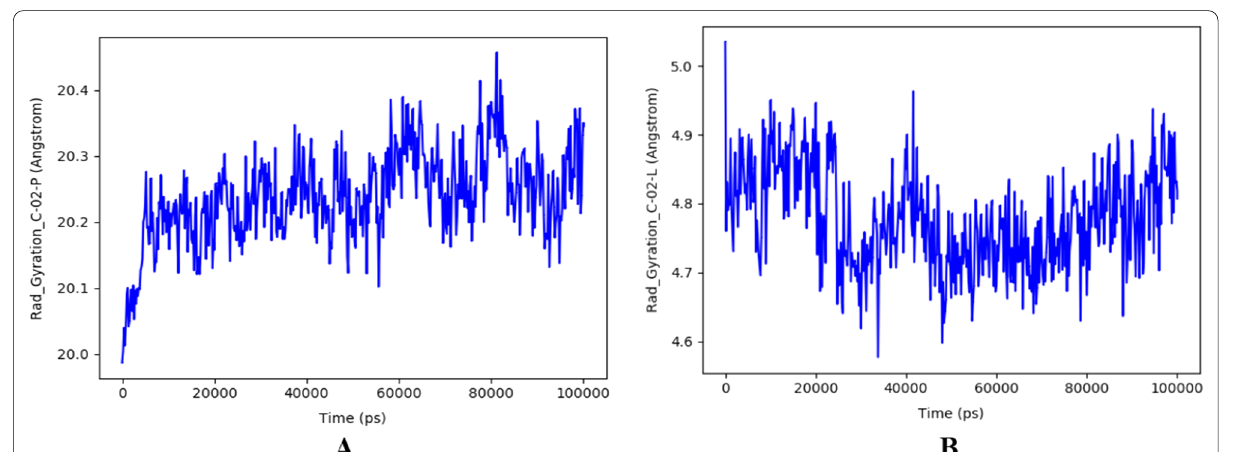
Fig. 6 Radius of gyration showing compactness for A Pf- DHODH B ligand, derivative C-02 showing a tolerable deviation during the simulation